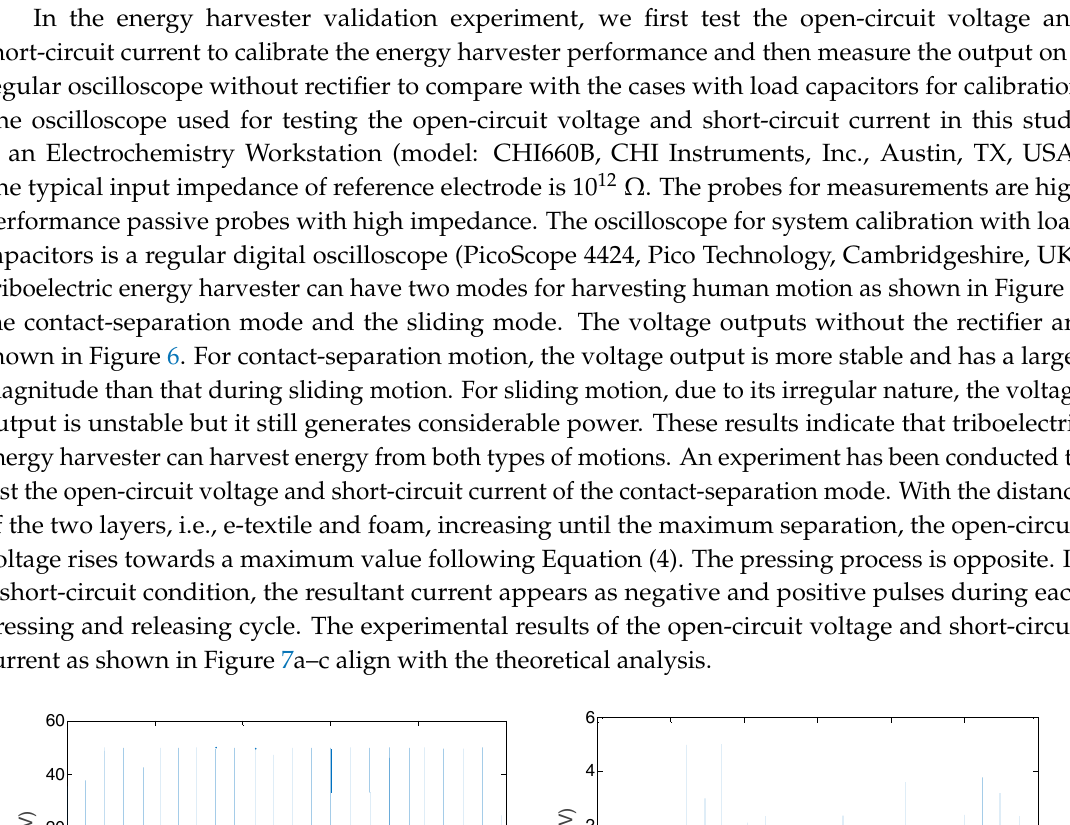
Figure 7. Open-circuit voltage and short-circuit current of the triboelectric energy harvester (PTFE and copper, pressing model). ( a ) The open-circuit voltage; ( b ) the enlarged figure of one period in ( a ); ( c ) short-circuit current. To select the two contact textile materials as discussed in Section 2.2, an experiment was first conducted in the study to investigate the triboelectric property of flexible textile materials including cotton, polyester, paper and foam. In the experiment, we prepared the samples of each material and slid them on the same copper substrate. A surface charge measurement device (USSVM2, AlphaLab Inc., Salt Lake City, UT, USA) was used to detect the surface voltage after each sliding. The charge accumulation can be clearly observed from the experiment that the surface voltage significantly increased with the sliding times. In the first experiment, we slid the four samples with copper substrate for five times and measured the surface voltage before and after sliding for all the four